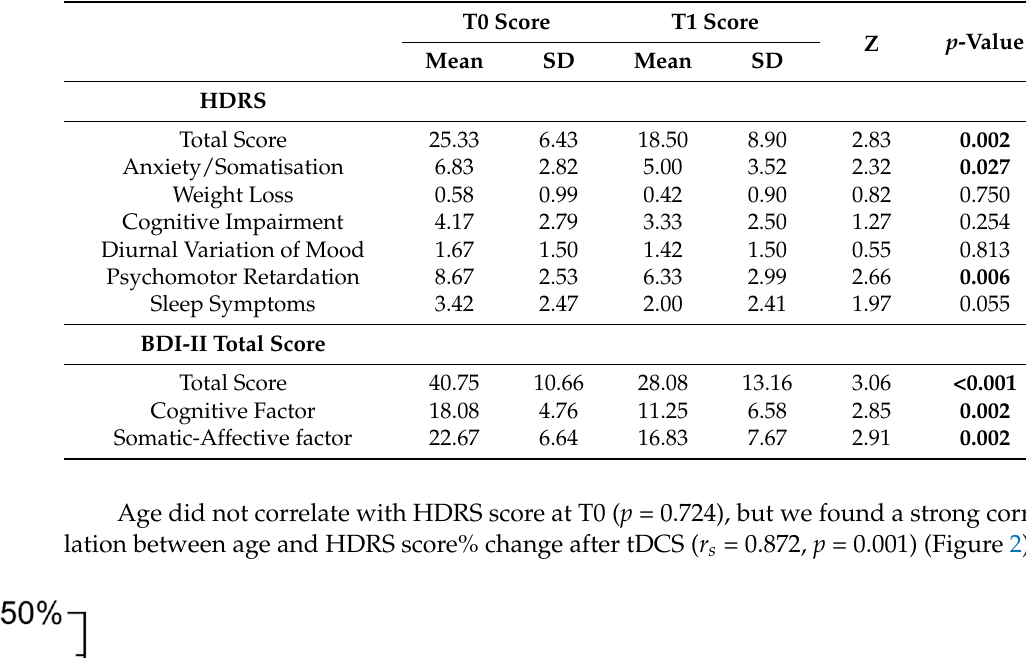
Table 1. Differences between psychological scores at T0 and T1.